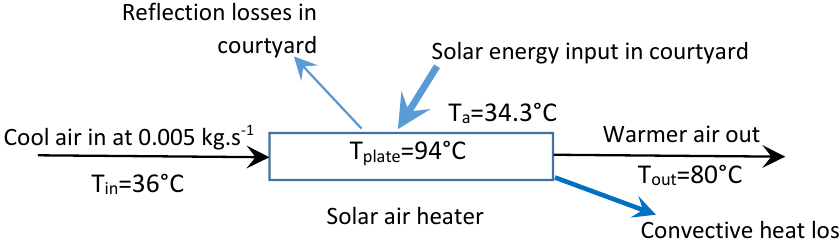
Figure 8. Schematic diagram of mass and energy flows in the experiments for performance evaluation and the heat loss measurements in the courtyard.